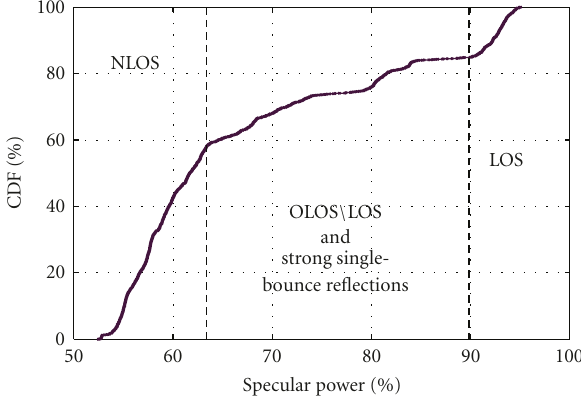
Figure 5: CDF of the specular power of the entire route.